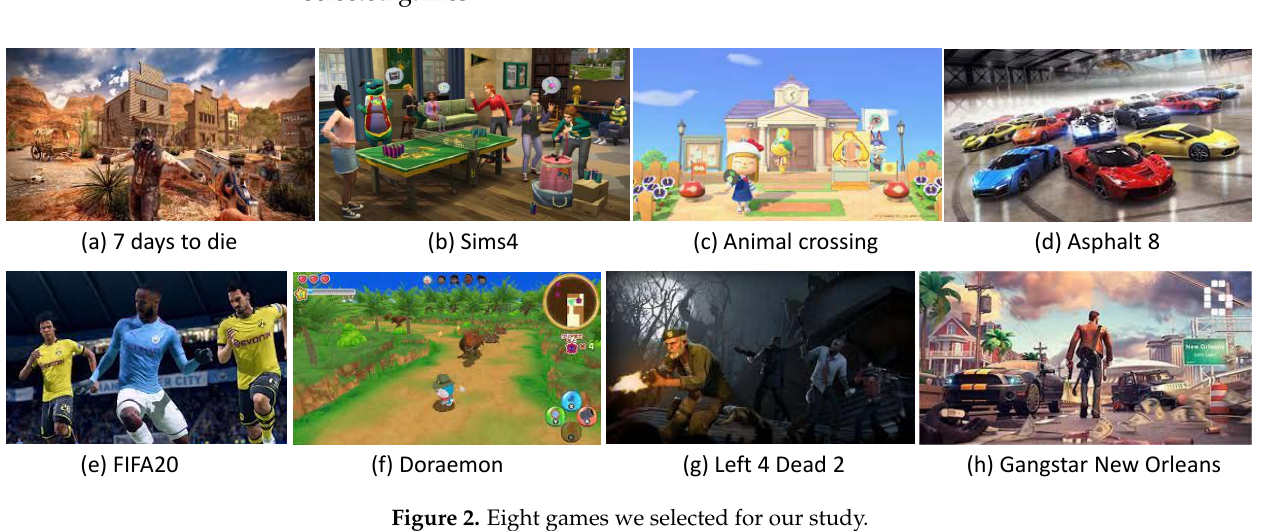
Figure 2. Eight games we selected for our study.